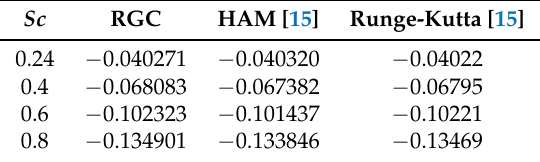
Table 5. Comparison of RGC, HAM and Runge-Kutta solution of C (cid:48) N = 0.8 and K = 0.2.